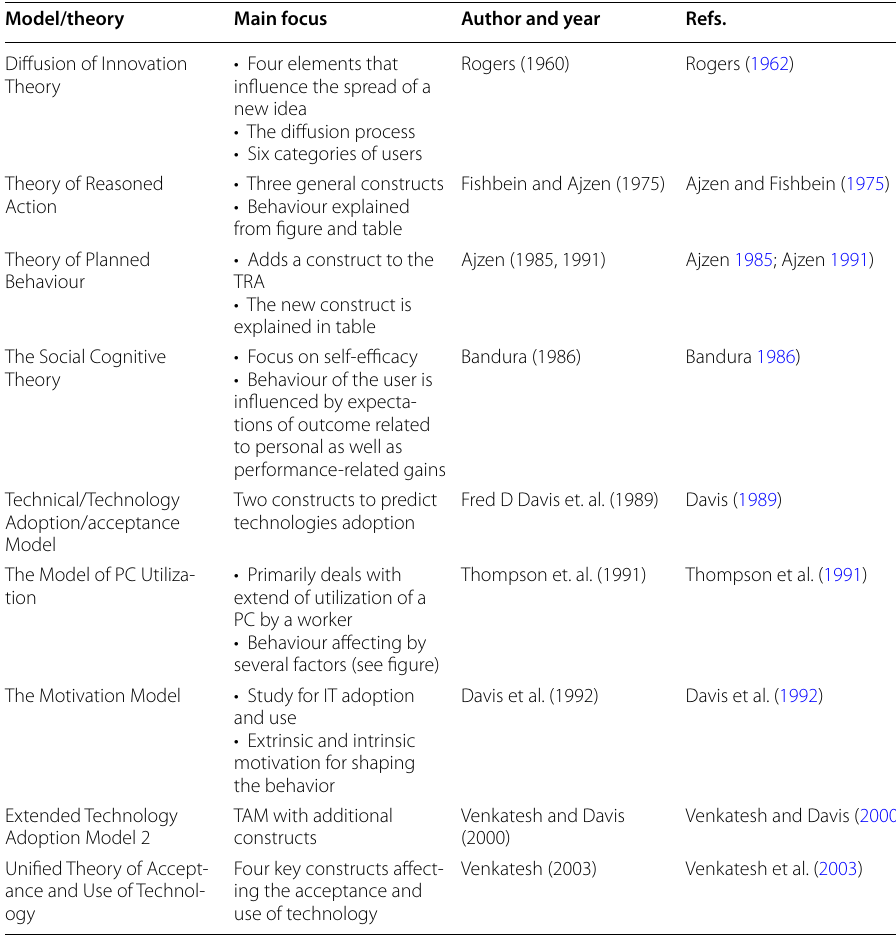
Table 9 The main focuses of the most popular technology adoption